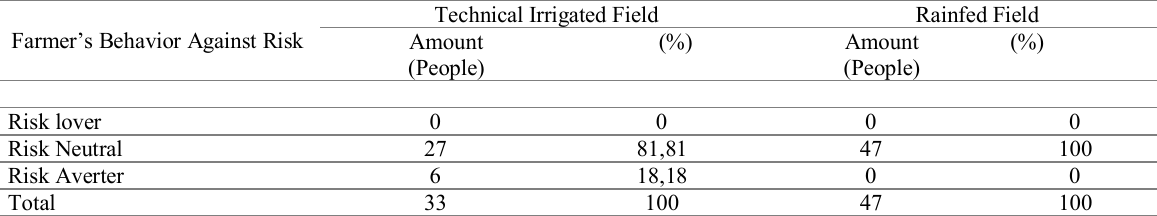
Table 4 : Farmer behavior against rice farming risk in South Lampung Regency, 2016 Farmer’s Behavior Against